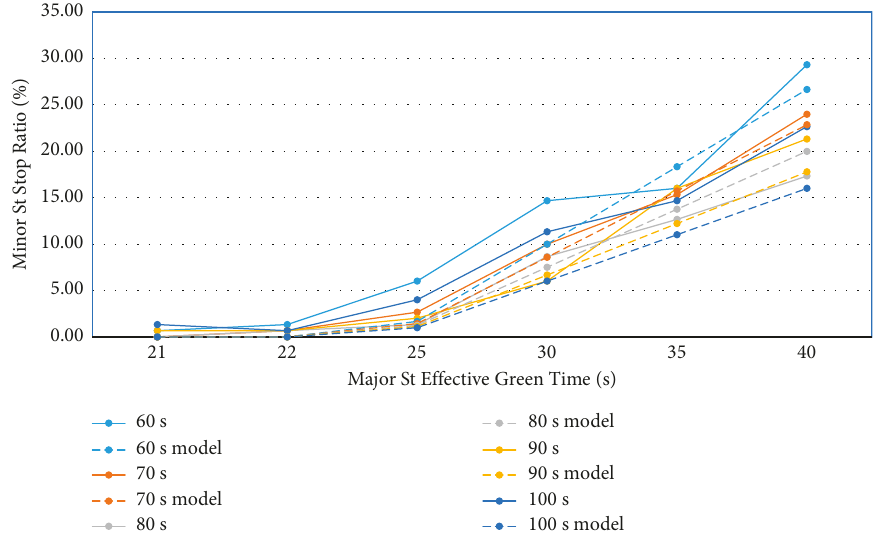
Figure 8: Minor St tolerance stop ratio of coordination plans under volume of 150vph.